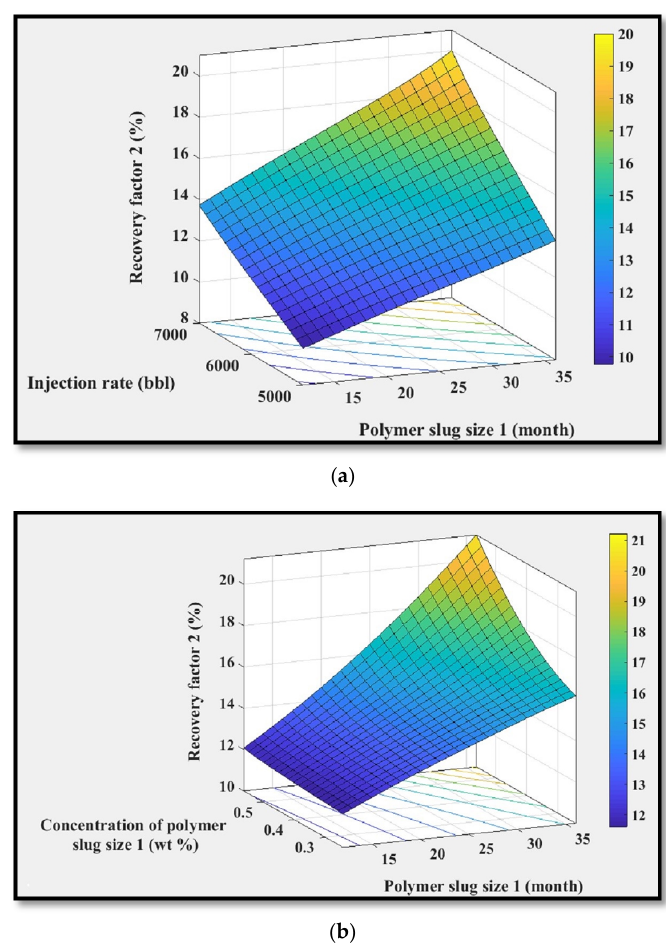
Figure 9. Description of the interactive effect of ( a ) polymer slug 1 size and injection rate on RF 2 , and ( b ) polymer slug 1 size and polymer slug 1 concentration on RF 2 .